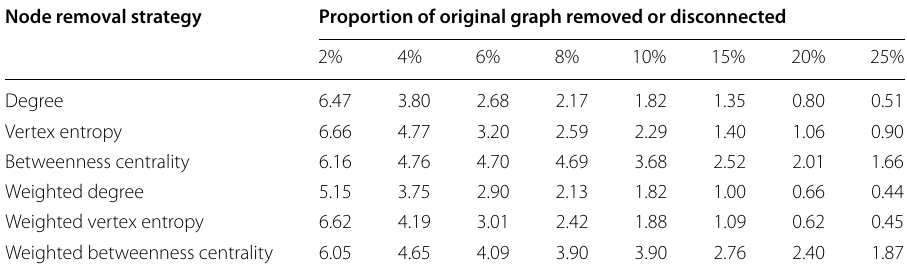
Table 2 Retained network capacity ( × 10 9 pkm ) for different proportions of removed and disconnected nodes under different node removal strategies